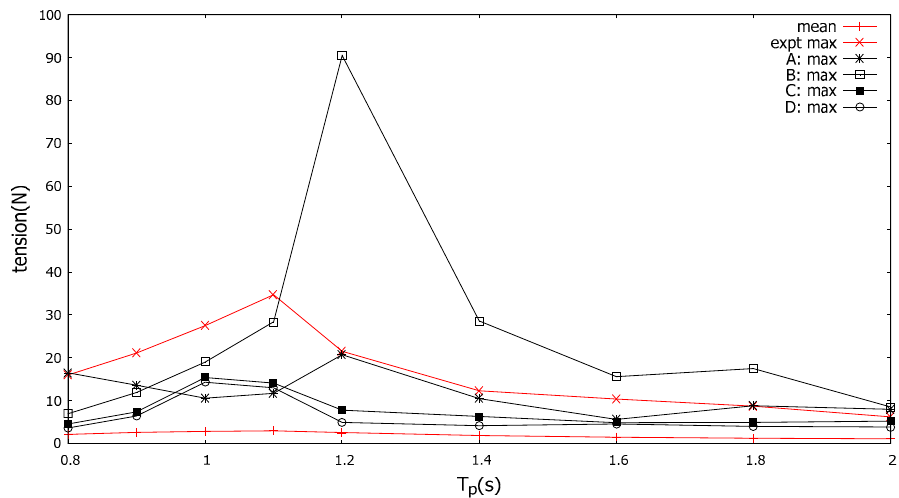
Figure 15. Variation of peak / maximum tension with T p for H s ≈ 0.06 m from linear di ff raction / radiation model with measured mean force and experiment.